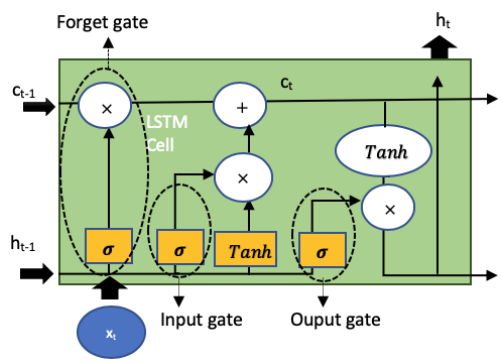
Figure 3. Architecture of an LSTM cell.